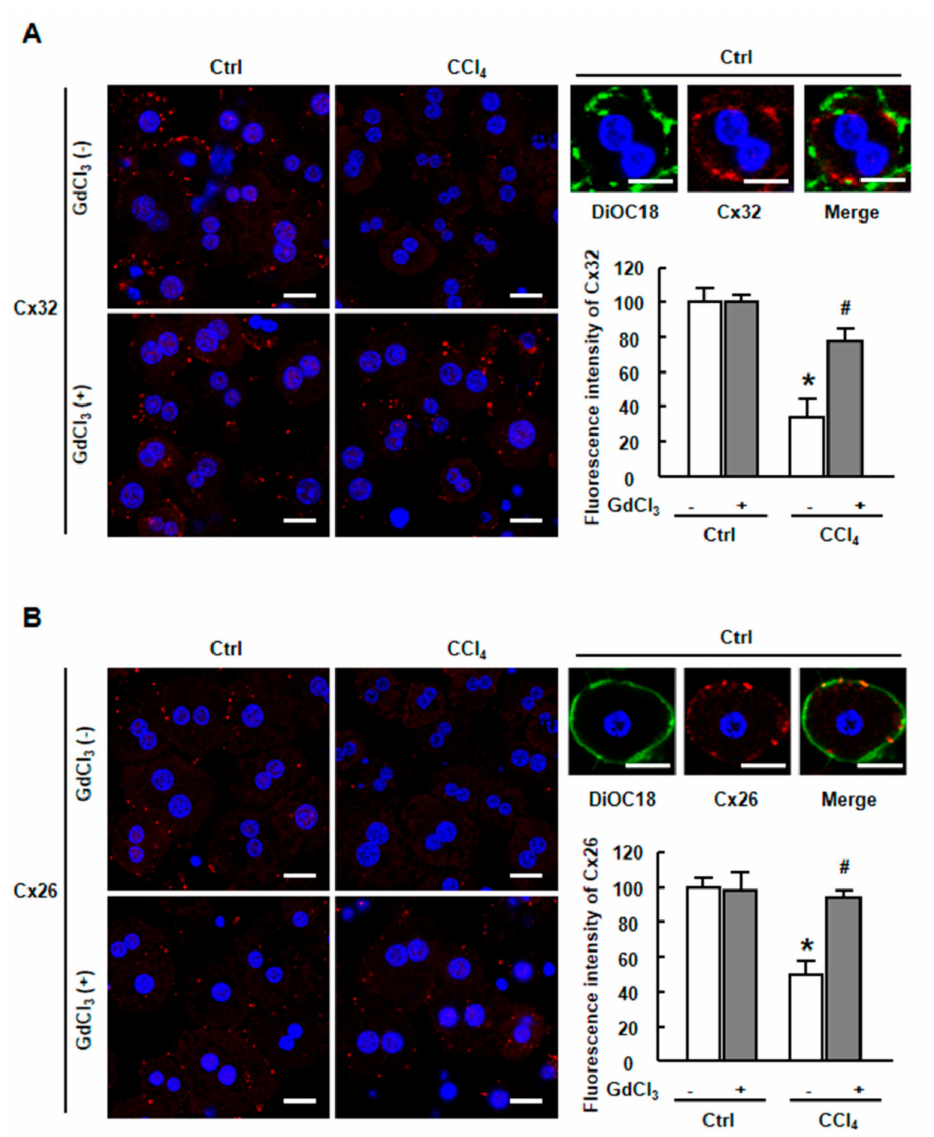
Figure 6. Immunofluorescence staining for Cx32 and Cx26 in CCl 4 -injured primary hepatocytes with or without GdCl 3 pretreatment. Immunofluorescence staining for Cx32 ( A ) and Cx26 ( B ) in Ctrl-treated, CCl 4 -treated, GdCl 3 plus CCl 4 -treated and GdCl 3 plus CCl 4 -treated hepatocytes. Scale bars, 20 µ m. The cell membrane was labeled with DiOC18, a membrane dye. Scale bars, 10 µ m. DAPI was used to visualize nuclei (blue). Data are presented as the mean ± SEM, and were analyzed by ANOVA for the analysis of variance. * p < 0.05 vs. Ctrl. # p < 0.05 vs. CCl 4 -treated hepatocytes without GdCl 3